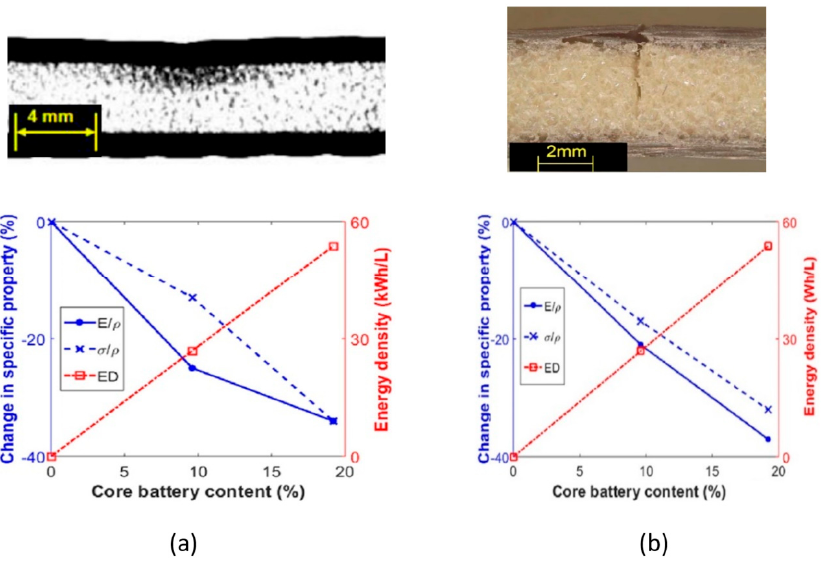
Figure 13. Failure modes of sandwich structures under three-point bending [10]. ( a ) 90 mm span. ( b ) 200 mm span.